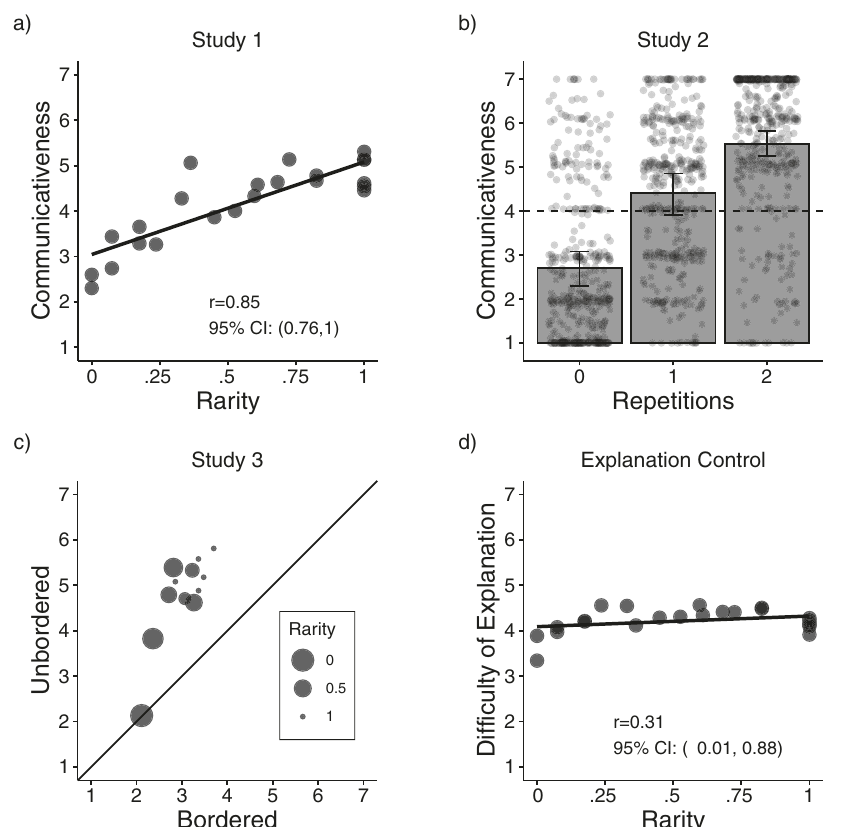
Fig. 2 Results from Studies 1 – 3 and the Explanation Control, combining original studies and their pre-registered replications. a Average communicativeness judgments (y-axis) as a function of the path ’ s rarity (x-axis) in Study 1 ( n = 60), operationalized here as deviation from the shortest path (see “ Methods ” ). b Average communicativeness judgments in Study 2 (y-axis) as a function of number of path repetitions (x-axis; n = 60). Vertical lines show bootstrapped 95% con fi dence intervals. Dots represent individual judgments. c Study 3 results as a function of rarity and condition. Each point represents a path with the average communicativeness in the bordered condition (x-axis) and the unbordered condition (y-axis). Smaller circles represent rarer paths. Points above the diagonal line indicate a higher communicativeness rating in the unbordered condition relative to the bordered condition. The difference across conditions was larger for paths with higher rarity in a mixed-effects model ( β rarity:condition = 1.14, p = 0.002, n = 30; replication: